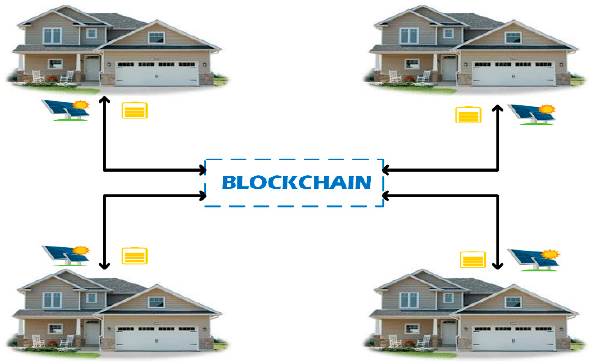
Figure 2. Illustration of Interconnected Energy Sharing (IES) operating strategy.